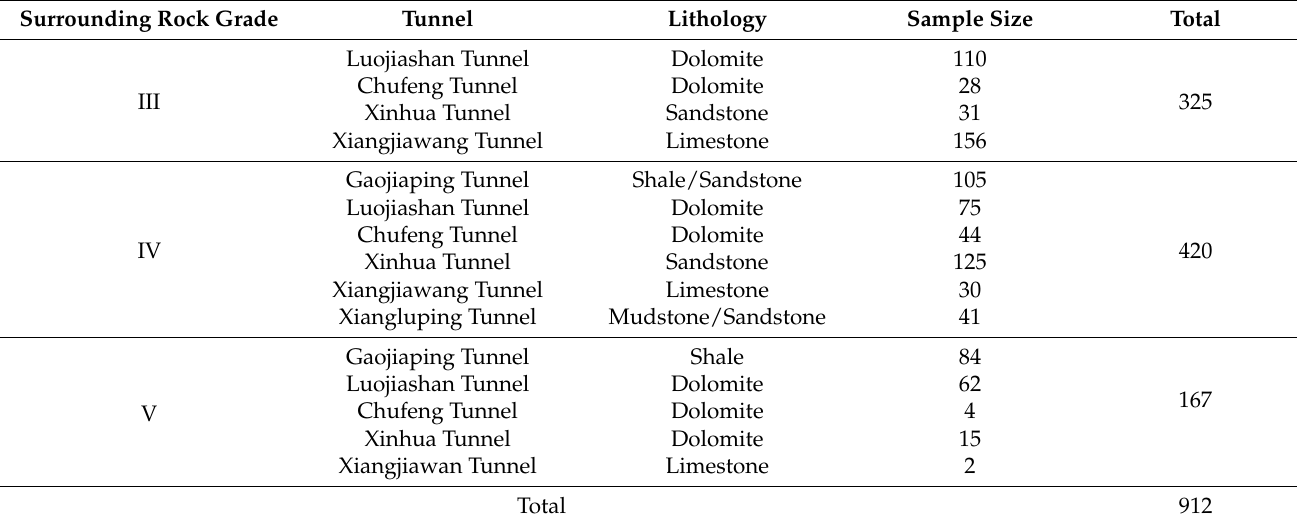
Table 3. Intelligent surrounding rock classification sample